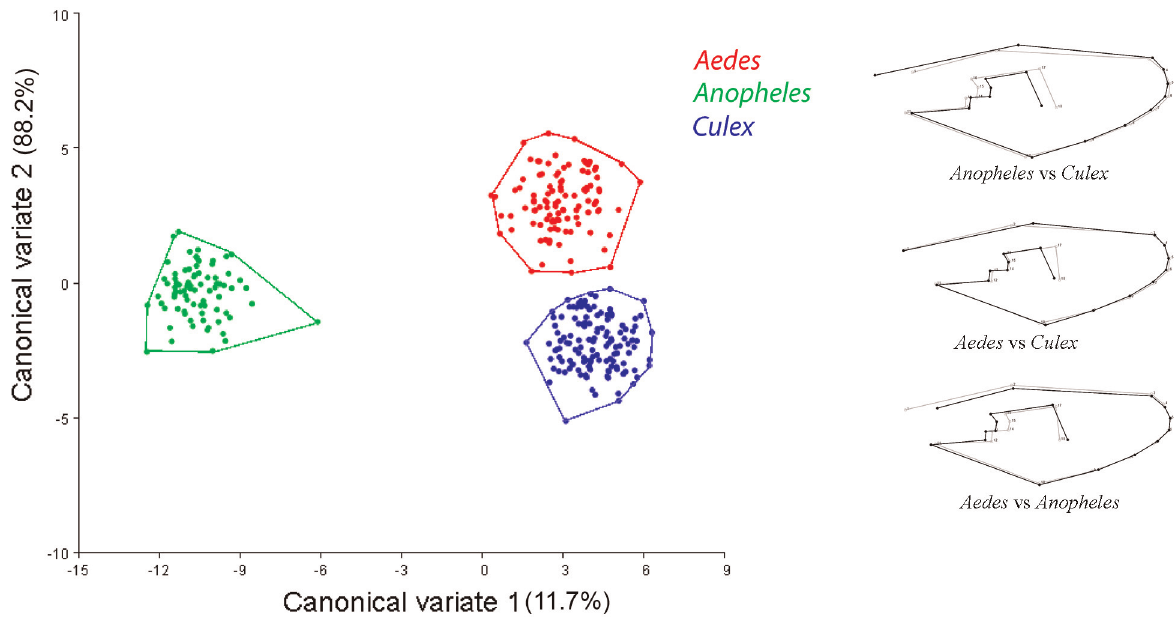
Fig 1. Morphological space produced by CVA of the three mosquito genera. Shape variations in a wireframe graph are shown to the right of the morphological space.